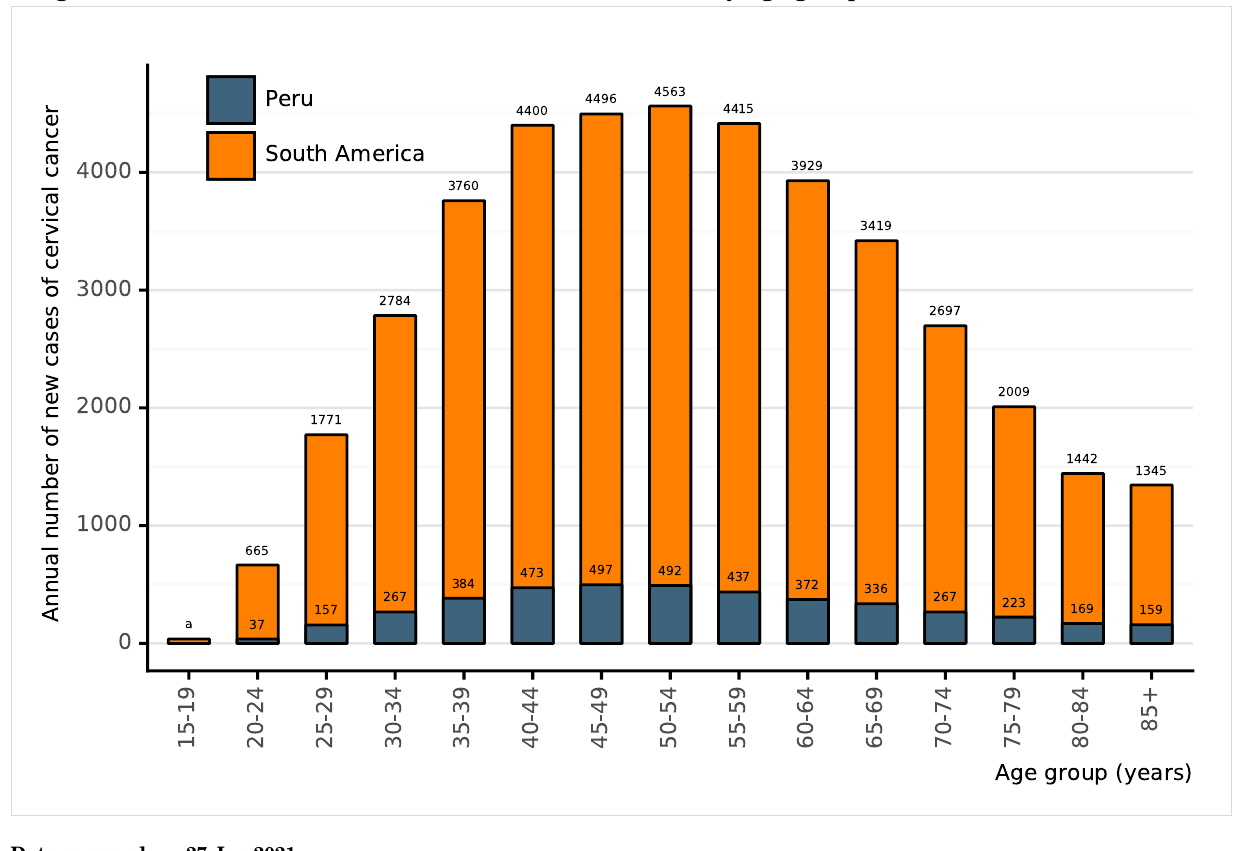
Figure 74: Annual number of new cases of cervical cancer by age group in Peru (estimates for